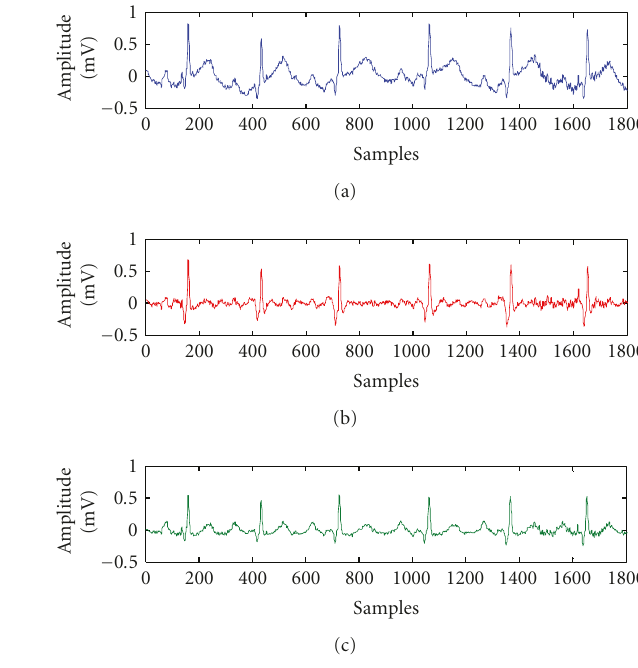
Figure 10: Typical results of di ff erent methods for baseline wander- ing cancellation in presence of sinusoidal drifts. (a) MIT-BIH record 228, (b) result of applying WT, (c) result of applying MABWT.